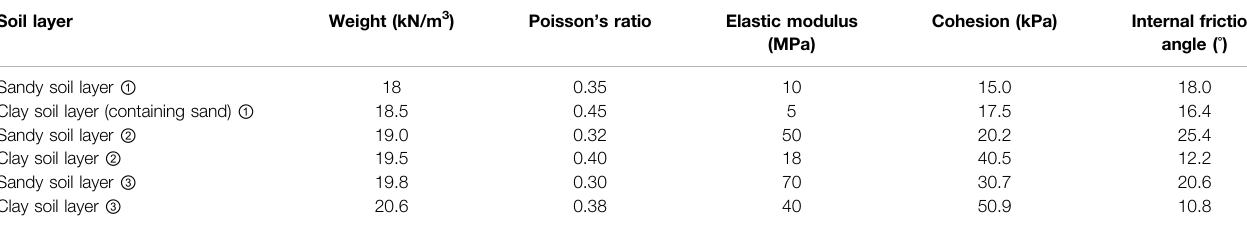
TABLE 1 | Physical and mechanical parameters of different soil layers. Soil layer